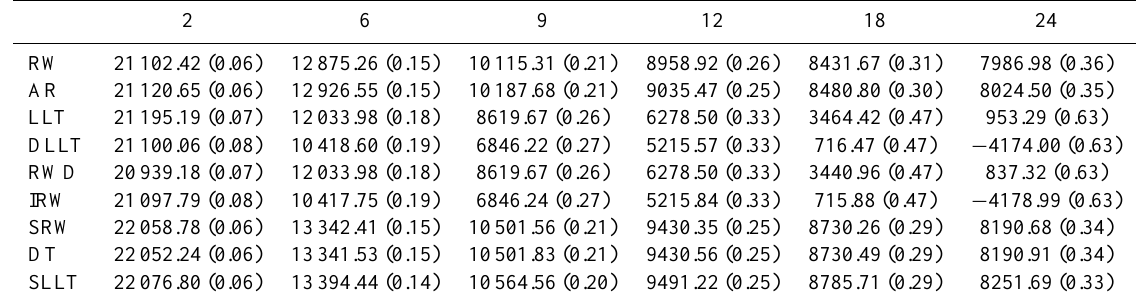
Table 2. Calibration results for Welsh bridge showing the log likelihood and RMSE (bracketed) for various forecast lead times (hours) and GRW